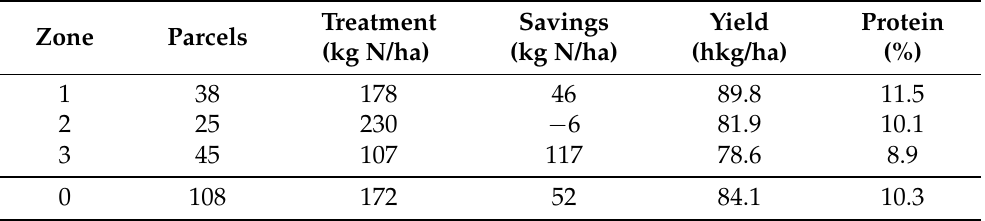
Table 7. Expected savings and mean performance for each zone at Kalundborg.